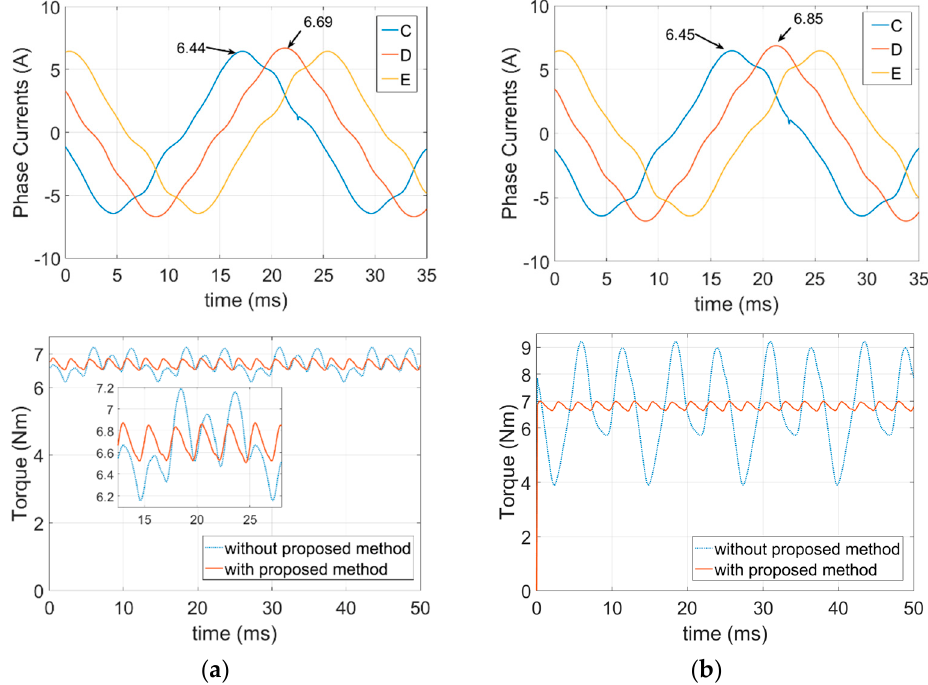
Figure 13. FEA torque waveforms for the fault-tolerant control currents of the ADPOC condition with and without the proposed method: ( a ) Only fundamental; ( b ) fundamental plus third harmonic.